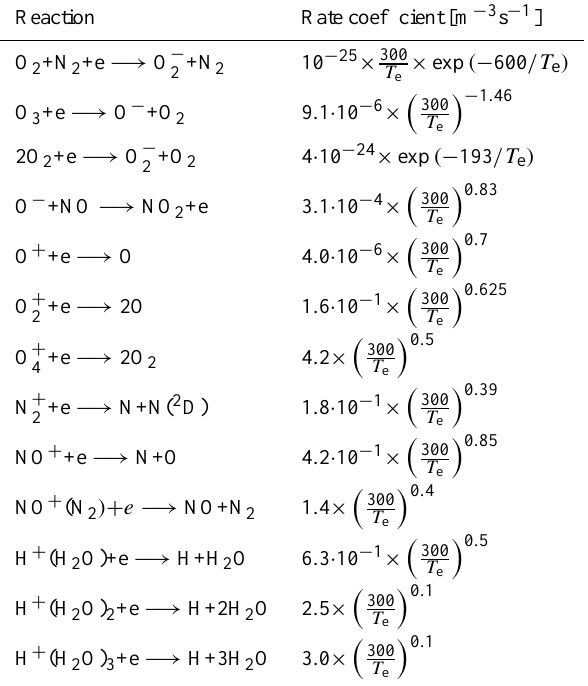
Table 1. The electron temperature dependent recombination and attachment reactions in SIC. For sources, see Turunen et al. (1996).